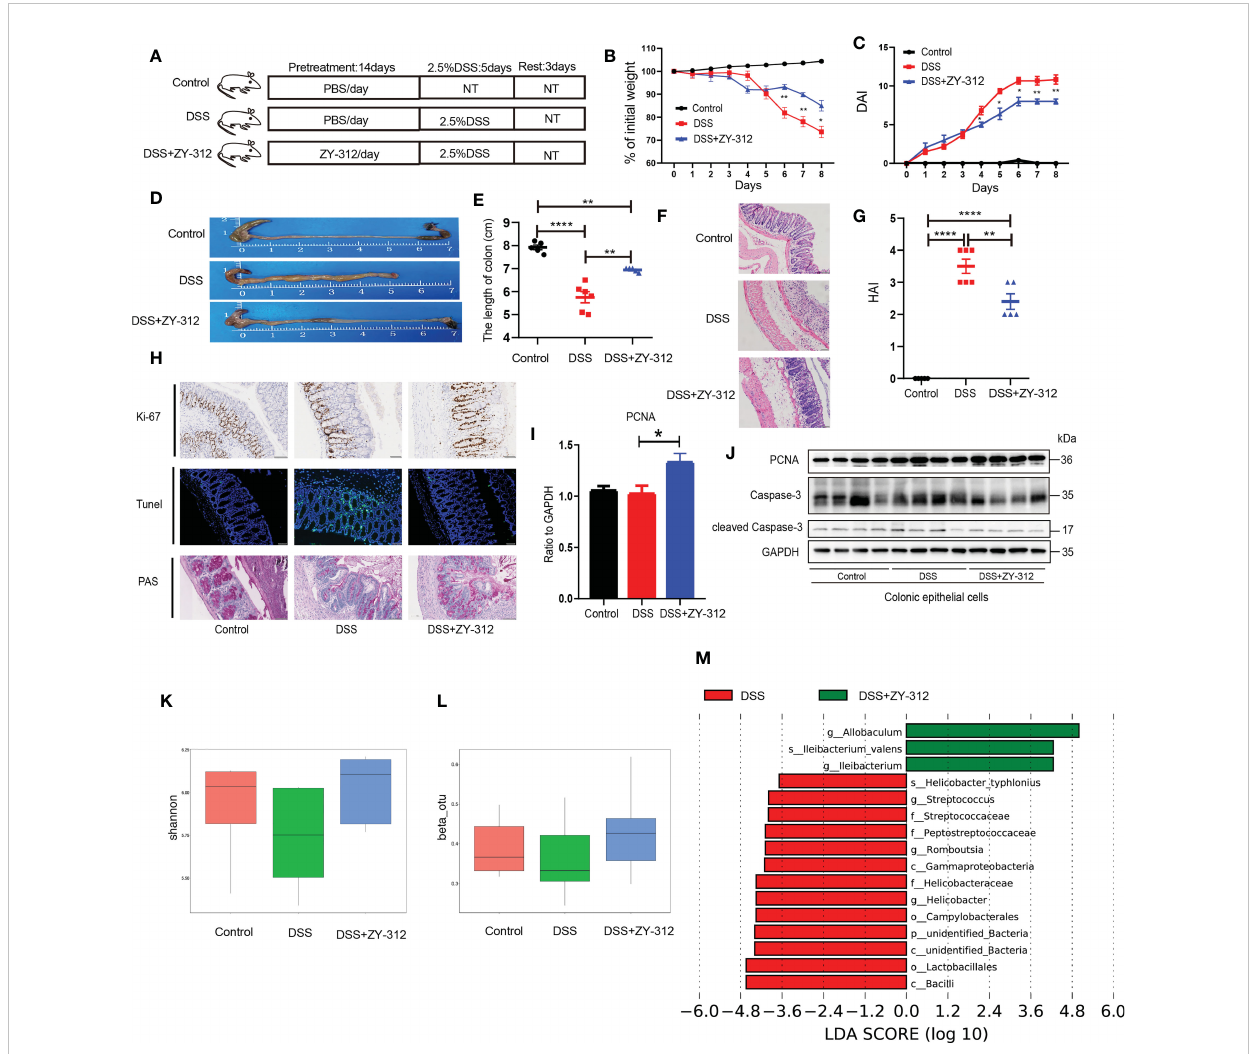
FIGURE 1 B. fragilis alleviated DSS-induced colitis by promoting colonic mucosa proliferation and mucus secretion, inhibiting apoptosis. (A) The route of the DSS-induced experimental colitis mouse model was as follows, mice were pretreated with B. fragilis strain ZY-312 (1x10 9 CFU) (DSS+ZY-312 group) or phosphate buffer (PBS) (DSS group) for 14 days orally. Next mice were treated with 2.5% DSS for 5 days, then sacri fi ced 3 days after DSS withdrew, Control group (N=5), DSS group (N=6), and DSS+ZY-312 group (N=5). N, number of mice, NT means no treatment. (B, C) Percent of weight loss (B) and disease activity index (DAI) (C) were monitored daily starting from DSS administration. (D) Representative of colon morphology. (E) The colon length of mice. (F) H&E staining of colon tissues. Scale bars, 200 m m. (G) The histopathological associated index (HAI). (H) Immunochemistry analysis of the level of Ki-67 (upper), Immuno fl uorescence analysis of Tunel (middle), PAS staining of mucus in colon sections (below). Scale bars, 200 m m. (I) Quantitative PCR (qPCR) analysis of PCNA in colon tissue. (J) Western blot analysis of PCNA and cleaved Caspase-3 in colonic epithelial cells. (K, L) The a (K) and b (L) diversity analysis of microbiota between groups. (M) LEfSe analysis of differential bacteria in feces between the DSS group and ZY-312 group with different levels meeting a signi fi cant LDA threshold value of >2.5. Data are presented as Mean ± SEM (B, C, E, G, I, K) . Statistical analysis was performed using two-way ANOVA (B, C) , and one-way ANOVA (E, G) . * p < 0.05,** p < 0.01, **** p <